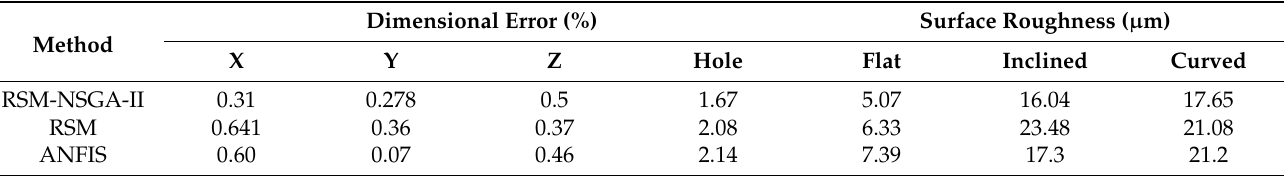
Table 8. The values returned by the predictive techniques were in close proximity to those suggested by the hybrid RSM-NSGA-II approach for the best run. Table 8. Predicted responses for obtaining the best part quality.